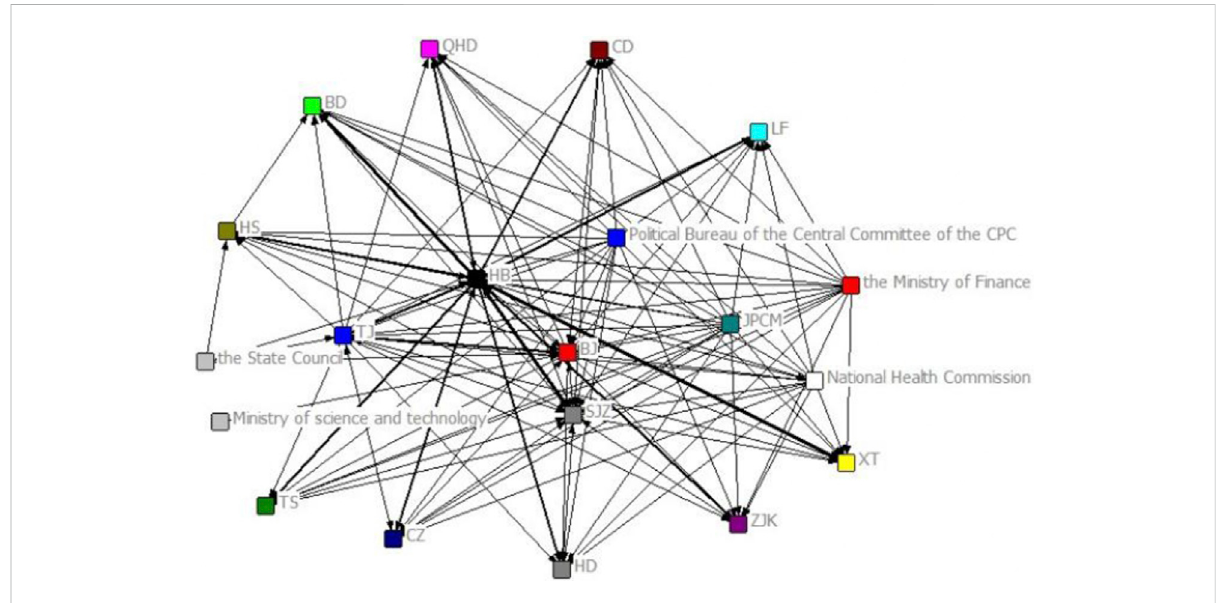
FIGURE 1 map of the ECSNs for COVID-19 in the B-T-H